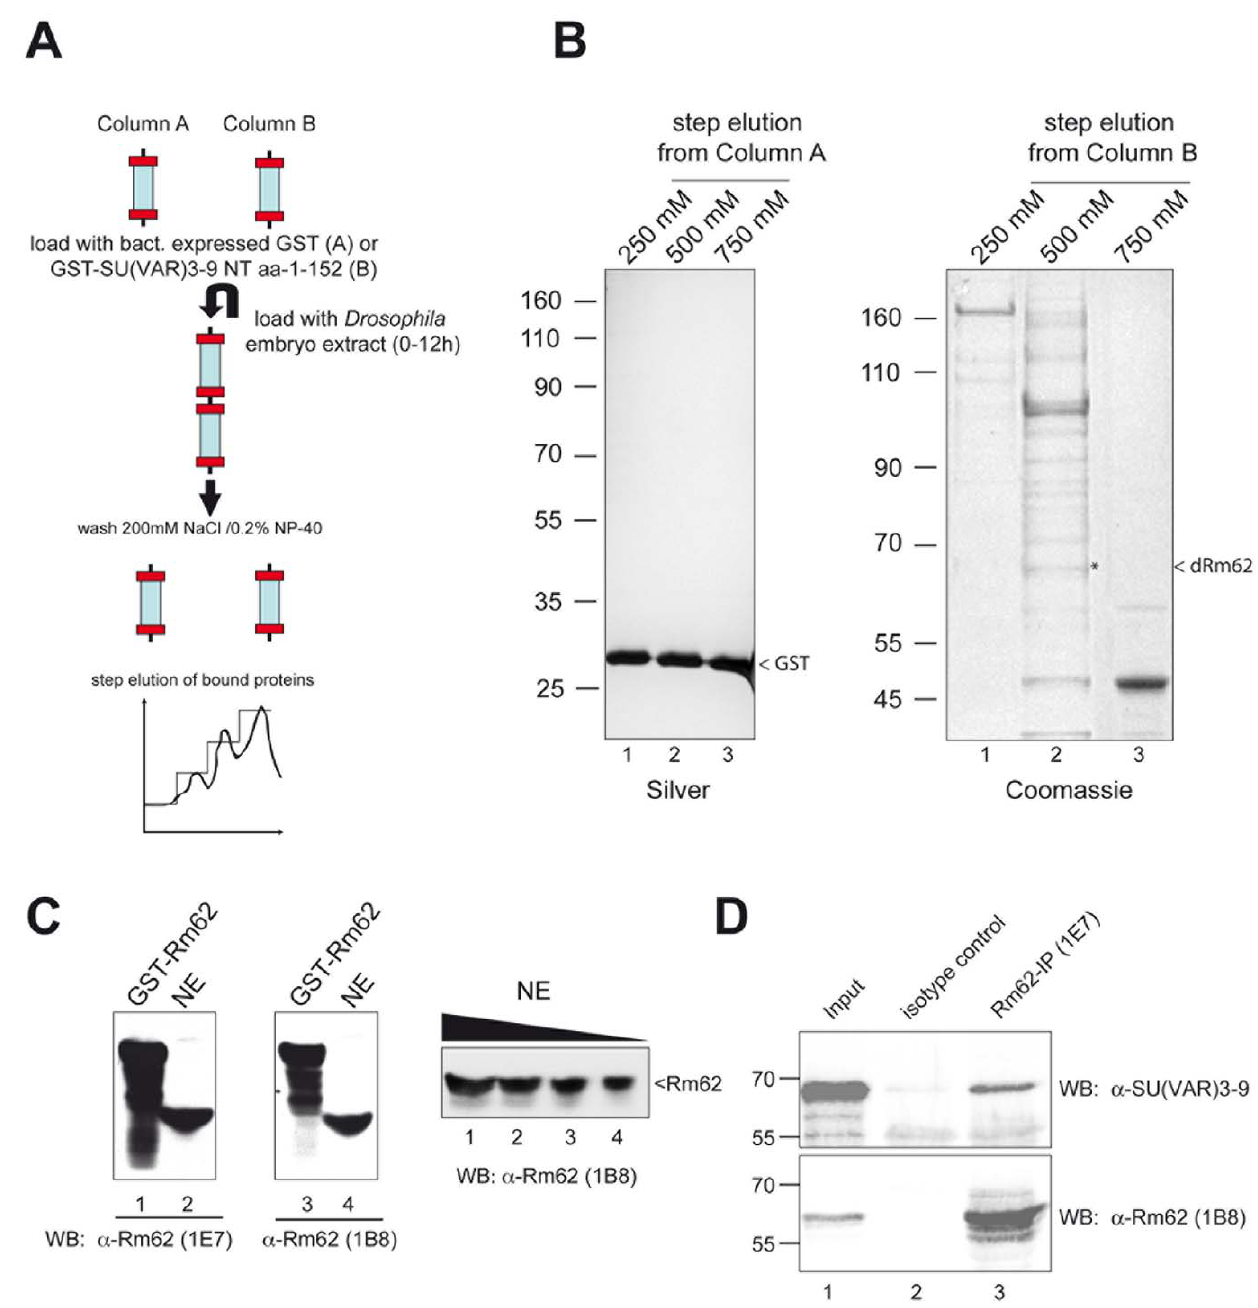
Figure 1. Identification of the DEAD-box RNA helicase Rm62 as an interaction partner of SU(VAR)3-9. ( A ) Schematic representation of the purification scheme used ( B ) Rm62 binds to the SU(VAR)3-9 N-terminus. left panel: Silverstain of a SDS-polyacrylamide gel loaded with salt eluted fractions from column A right panel: Coomassie staining SDS-polyacrylamide gel loaded with salt eluted fractions from column B. The band marked with the asterisk (*) was identified as Rm62 via mass-spectrometry. ( C ) The rat monoclonal antibodies 1B8 and 1E7 are specific for Rm62. Left: Western Blot analysis of recombinant and endogenous Rm62 probed with 1B8 or 1E7. Lane 1: purified recombinant GST-Rm62. Lane 2: 5 m l of a nuclear extract (NE) from Drosophila embryos (0–12 h a.e.l.). Right: Decreasing amounts of NE (lane 1–4: 10 m l, 5 m l, 2.5 m l, 1 m l) were separated by SDS-PAGE and subjected to Western Blot analysis using 1B8. ( D ) SU(VAR)3-9 copurifies with Rm62 in immunoprecipitations using the Rm62 specific antibody 1E7. NE of copper induced (0.2 mM) HA-SU(VAR)3-9 expressing cells were used for co-immunoprcipitation (Co-IP) experiments. NEs were incubated with 1E7 antibody and Rm62 was purified by the addition of Protein A/G sepharose beads (GE Healthcare). Bound proteins were eluted with SDS sample buffer and subjected to gel electrophoresis followed by western blotting (Input: 5% of the amount of NE used for the Co-IP, beads: unspecific control using either an antibody of the same isotype (isotype control, IgG2c) Rm62-IP (1E7): Co-IP with the 1E7.